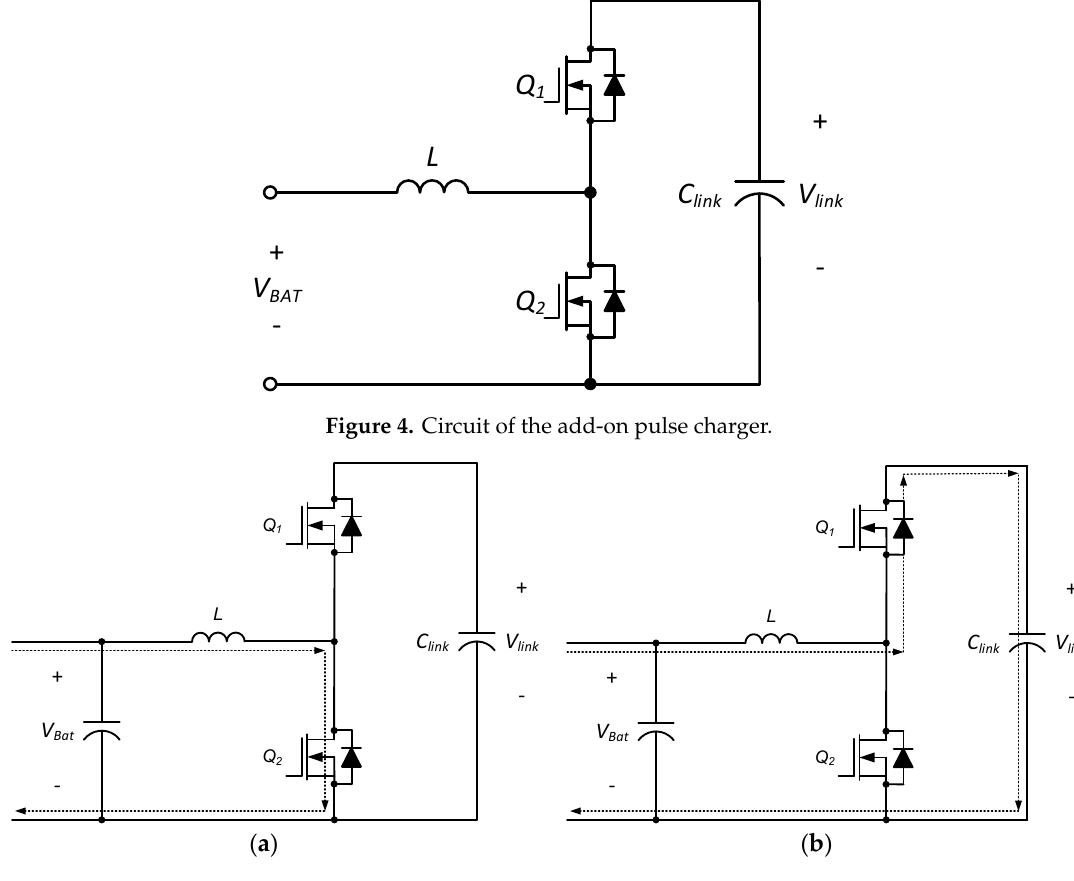
Figure 5. Capacitor charge mode ( a ) Q 1 : turn off, Q 2 : turn on, ( b ) Q 1 : turn on and Q 2 : turn off.